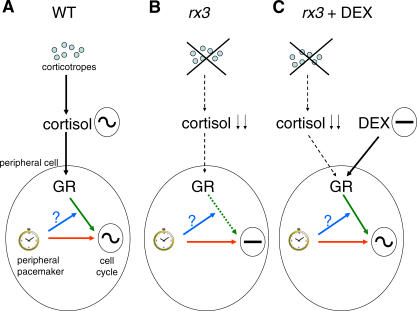
Working Model for Glucocorticoid Action on Circadian Cell Cycle Rhythms(A) In wild-type larvae, corticotrope function is associated with normal cortisol levels (that exhibit circadian cycling). In target cells, cortisol activates GR signaling (green arrow) that may be permissive for the peripheral clock regulation of cell cycle. In addition, cycling cortisol levels may confer circadian rhythms of GR signaling that potentially reinforce cell cycle rhythmicity. The red arrow indicates the peripheral circadian clock control of cell cycle, and the blue arrow symbolizes the potential gating of GR signaling by the peripheral pacemaker. Cooperation between the peripheral clock mechanism and the GR signaling pathway generates a circadian rhythm of cell cycle.(B) In corticotrope-deficient mutants, circulating cortisol levels are significantly reduced. In the absence of normal GR signaling, peripheral clock input is not sufficient to generate cell cycle rhythms. Dashed arrows indicate attenuated pathways.(C) Cell cycle rhythms are rescued in corticotrope-deficient mutants by tonic dexamethasone (DEX) treatment. Thus timing information is provided by peripheral circadian clocks and is not reliant on cycling cortisol levels.